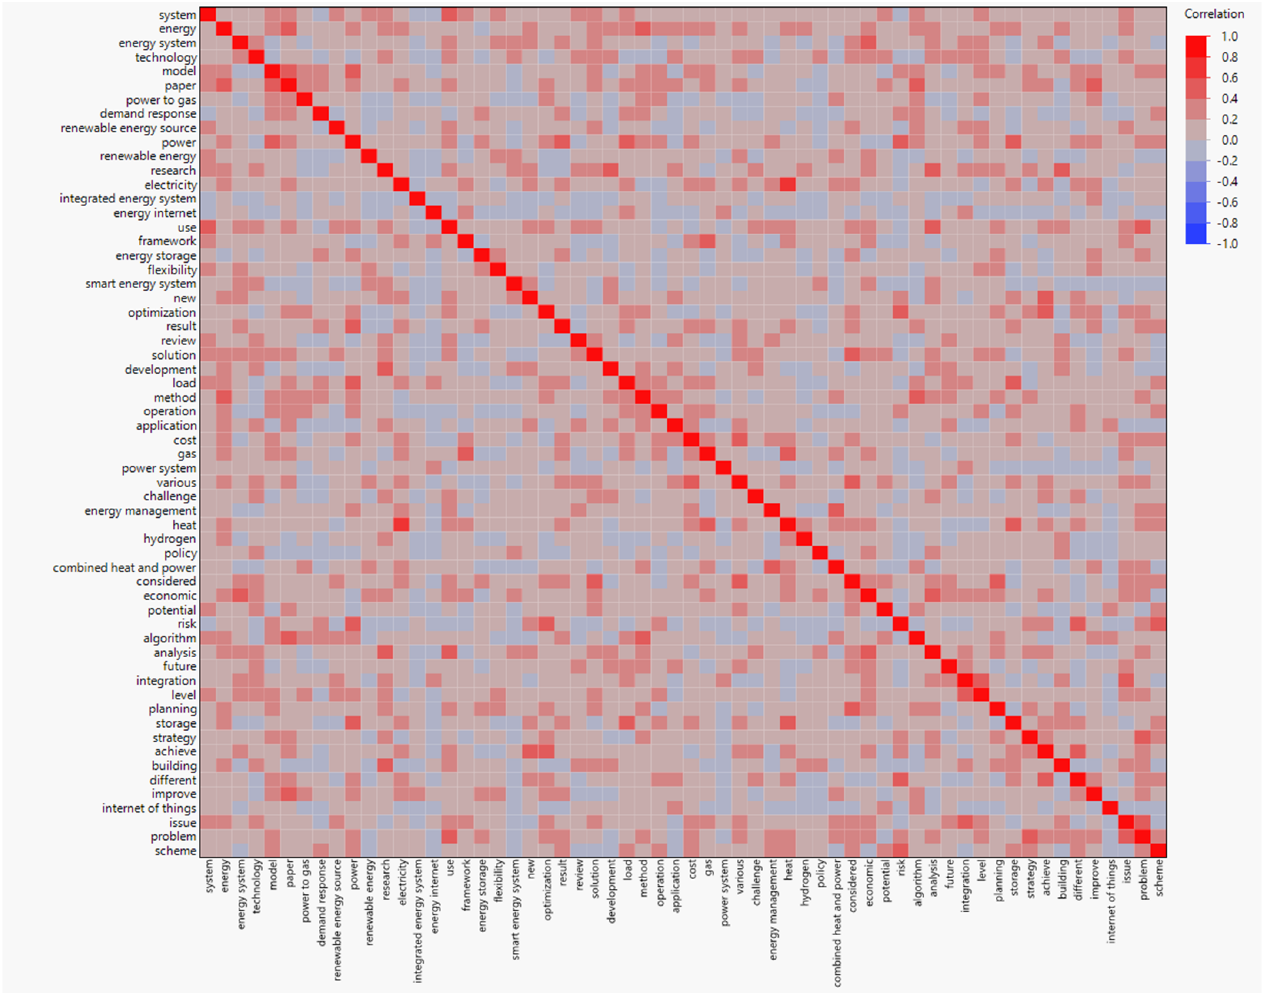
Figure 2. Map of correlation for the most common terms and phrases (own construction).